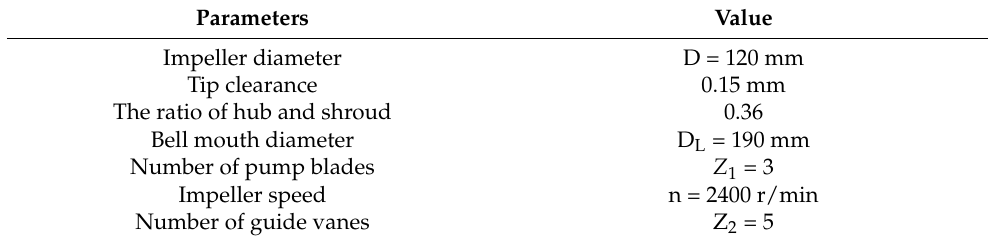
Table 1. Basic parameters of the hydraulic model of the axial flow pump.